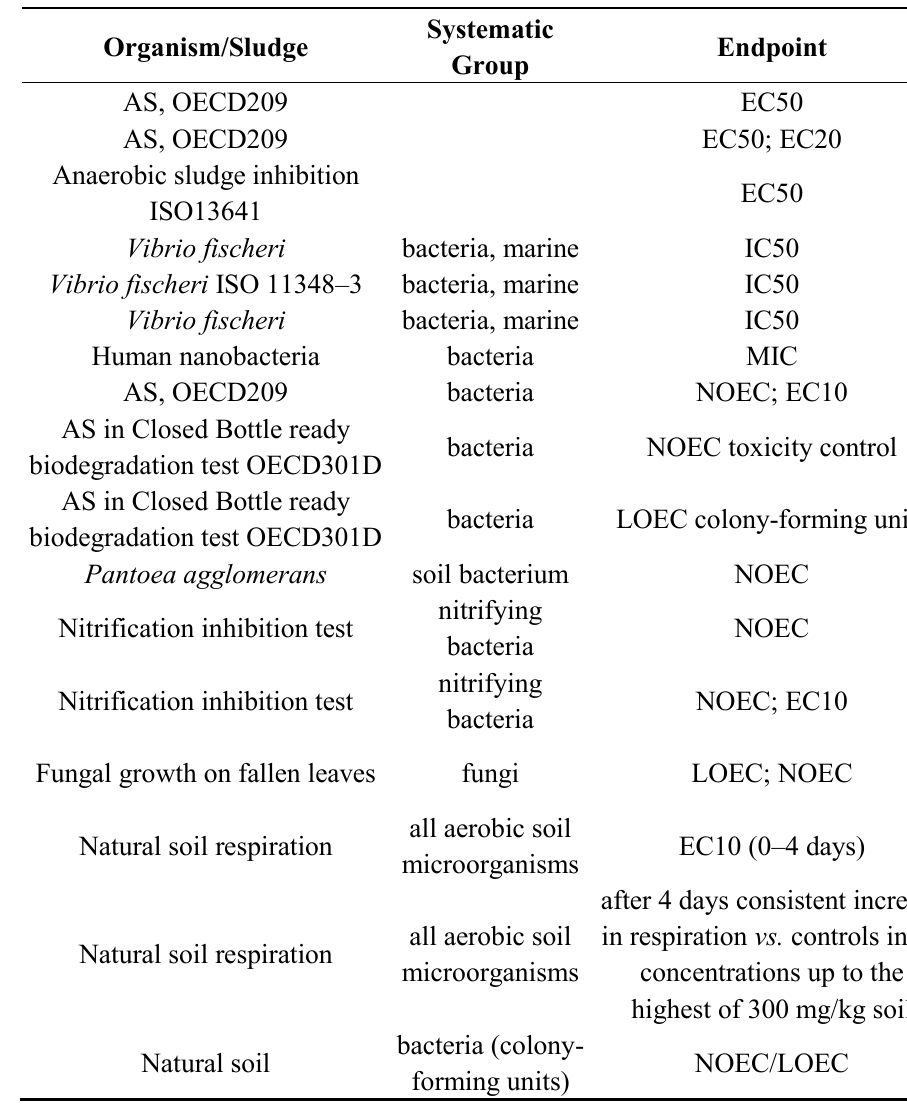
Table A6. Micro-organism and activated-sludge toxicity